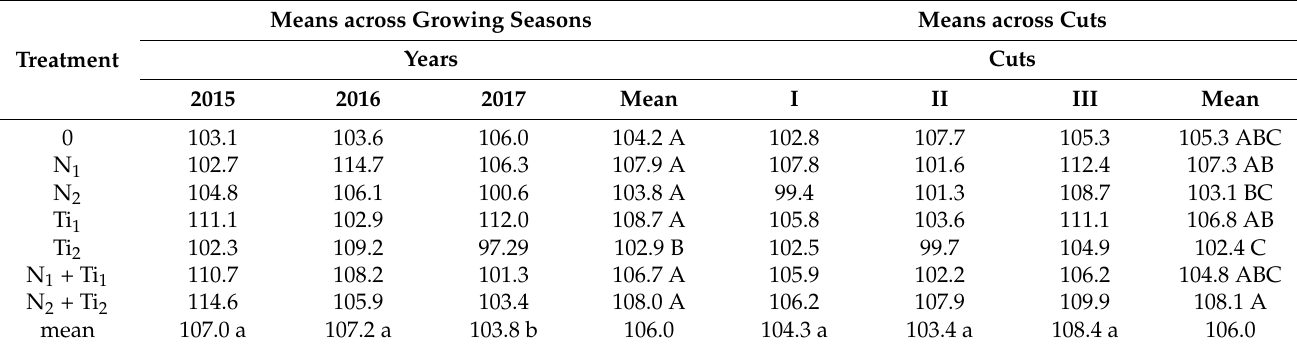
Table 8. Relative feed value (RFV) of Festulolium braunii dry matter.